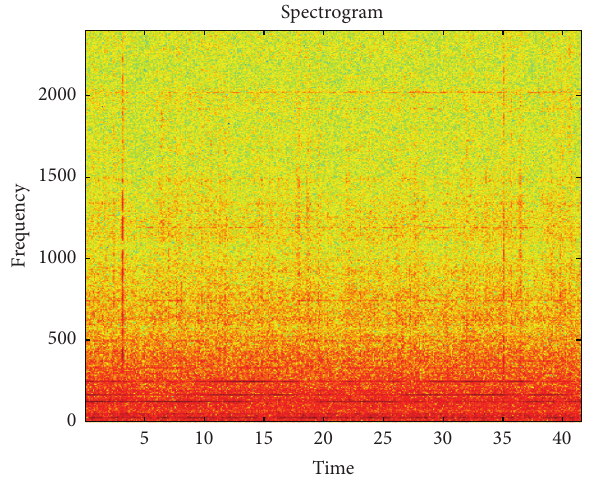
Figure 2: Spectrogram of acoustic signal. frequency of grinding table travel alongside the microphone was 10𝑓 0